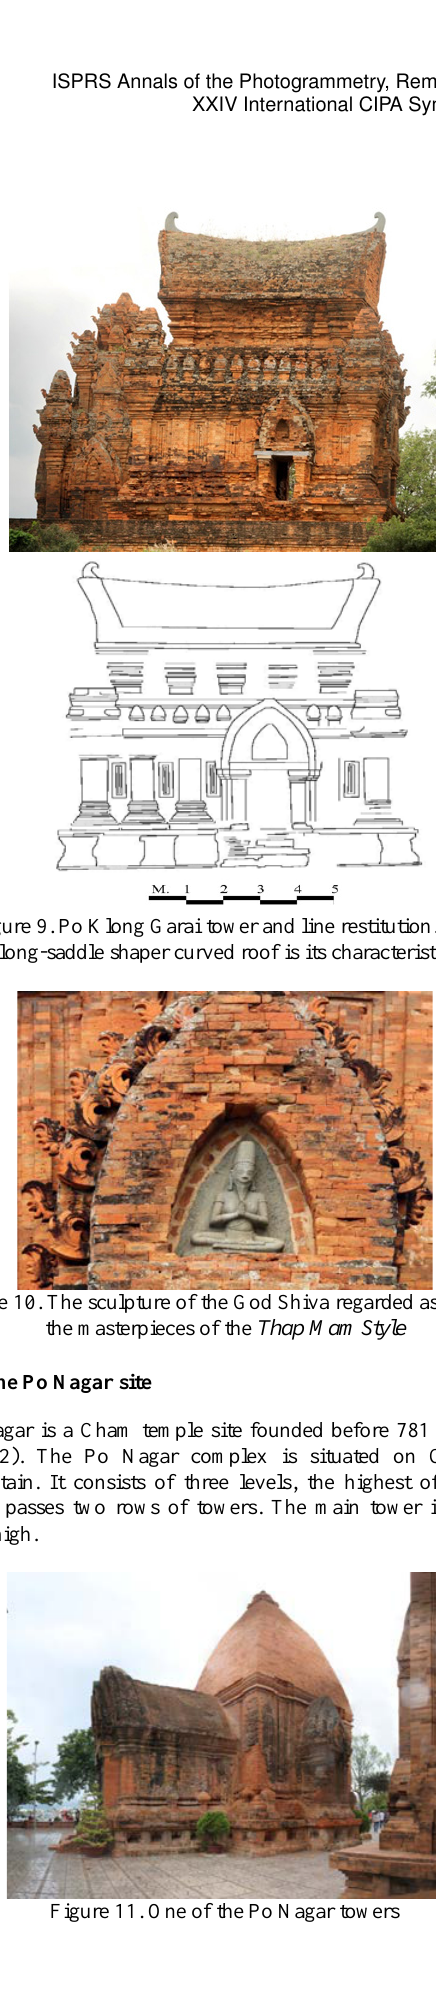
Figure 11. One of the Po Nagar towers